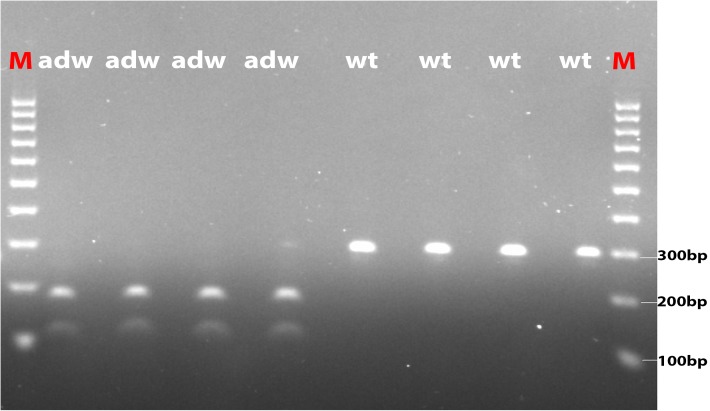
The photo of agarose gel of amplified fragments for genotyping candidate mutation in TMEM263. Autosomal dwarf (adw) and normal-sized (wt) samples were analyzed by PCR-RFLP method. Amplified DNA was digested with Ddel and separated by electrophoresis. Markers were used in both end lanes (M). The autosomal dwarf samples (adw/adw) were shown with two sequence fragments, around 109 and 184 bp, respectively, while the wild-type samples shown with one band on the right four lanes, the size is around 294 bp.